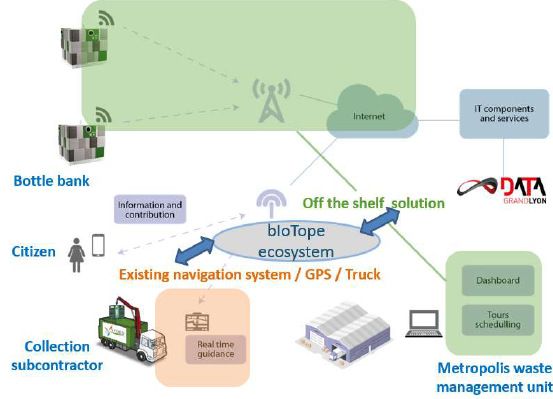
Figure 15. Target solution structure for bottle